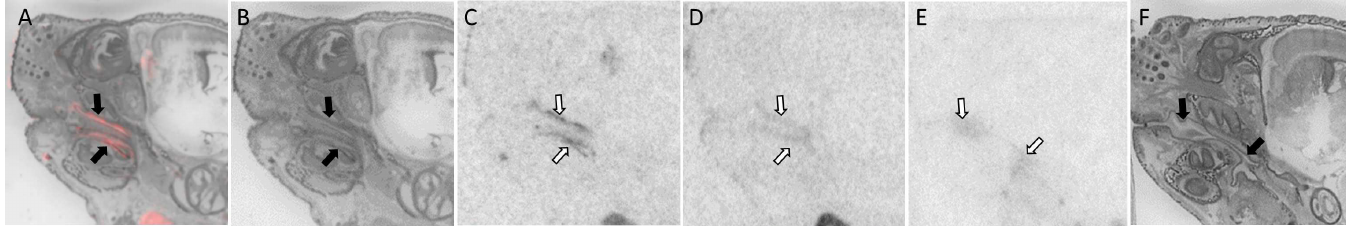
Fig 5. OXTR ligand binding in the periodontium of a P0 male mouse. Pseudo-color composite (OXTR in red, cresyl violet counterstain in gray) (A), followedby cresyl violet counterstain (B), with black arrows indicating regionof interest. OXTR ligandbindingis indicatedby white arrows in the 0 nM OXT competition(C), followedby 1000 nM OXT competing with OVTA radioligand to reduce the signal (D). OXTR ligandbindingwas not present in OXTR KO mice (E), followedby the post-processed cresyl violet tissue of the OXTR KO (F).